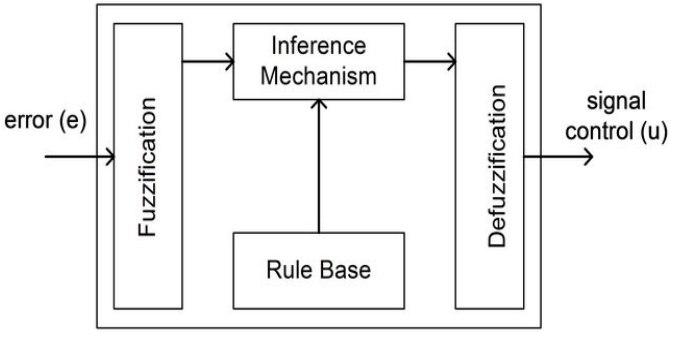
Figure 6. Outline of the validated fuzzy controller.